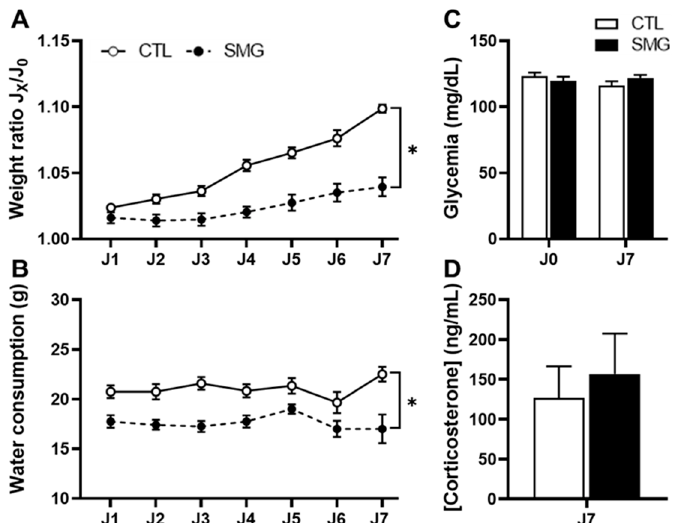
Figure 1. Physiological parameters of the rats during the experiment. ( A ). Ratio of the daily weight with respect to the initial weight over the 7 days of SMG. ( B ). Water consumption over the 7 days of SMG. ( C ). Glycemia measured at the beginning (J0) and at the end (J7) of the SMG. ( D ). Corti- costerone concentrations measured in blood collected at J7. All data are presented as mean ± sem ( n = 12 rats/group). * p < 0.05 (corresponding to two-way ANOVA followed by post-hoc test results).